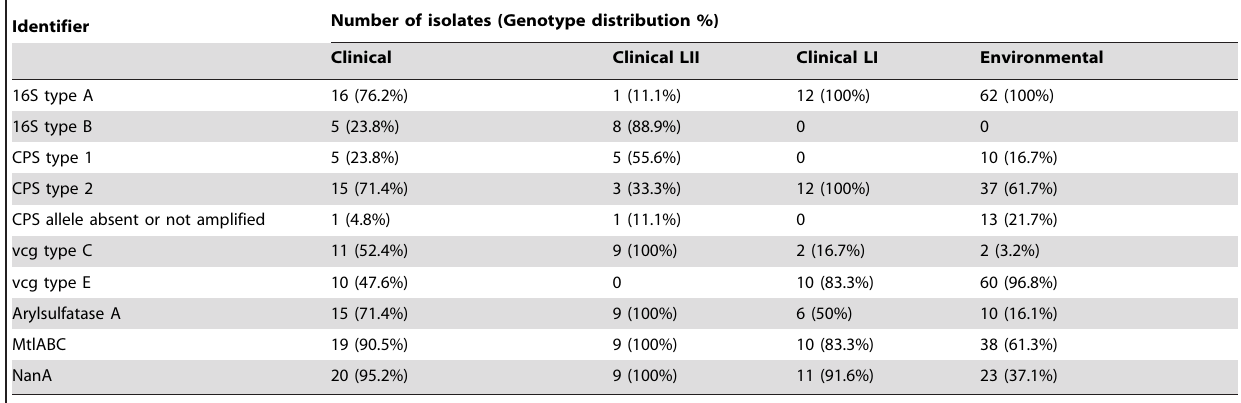
Table 4. Allelic distribution of markers studied in clinical versus environmental V. vulnificus